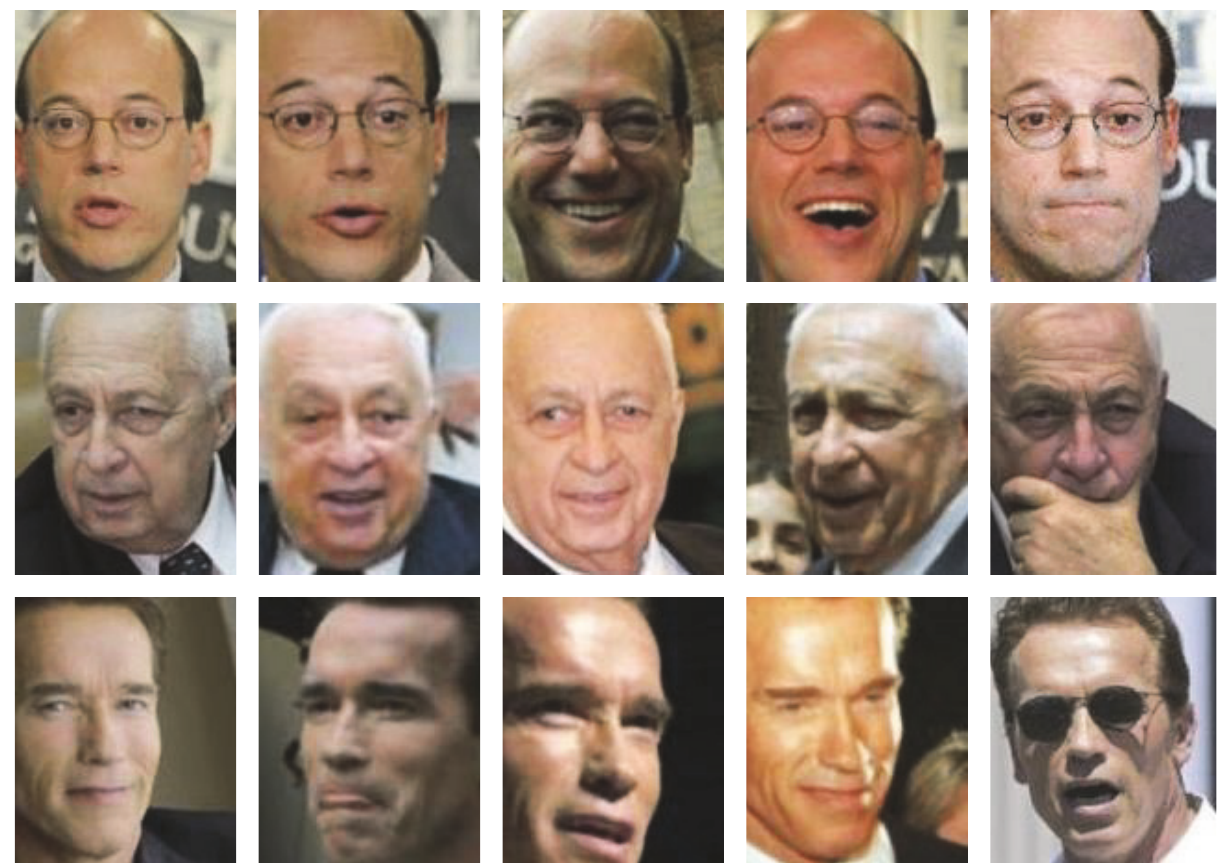
Figure 3: Some face images from the LFW face